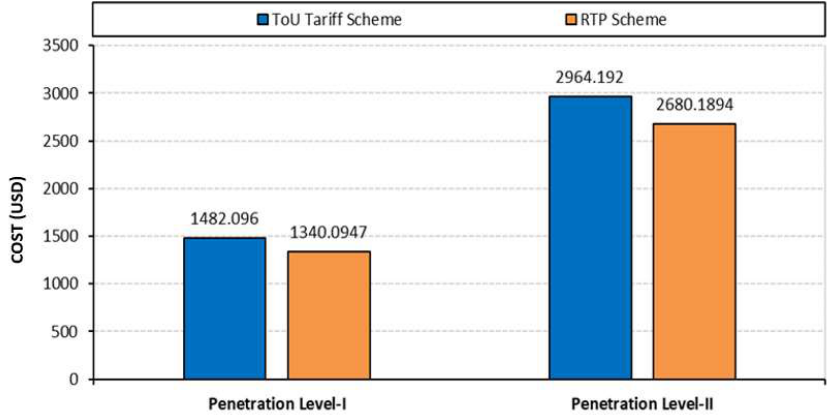
Figure 9. Impact of various tariff schemes on the charging cost . Table 4. Impact of EV charging on the network performance for all four cases.